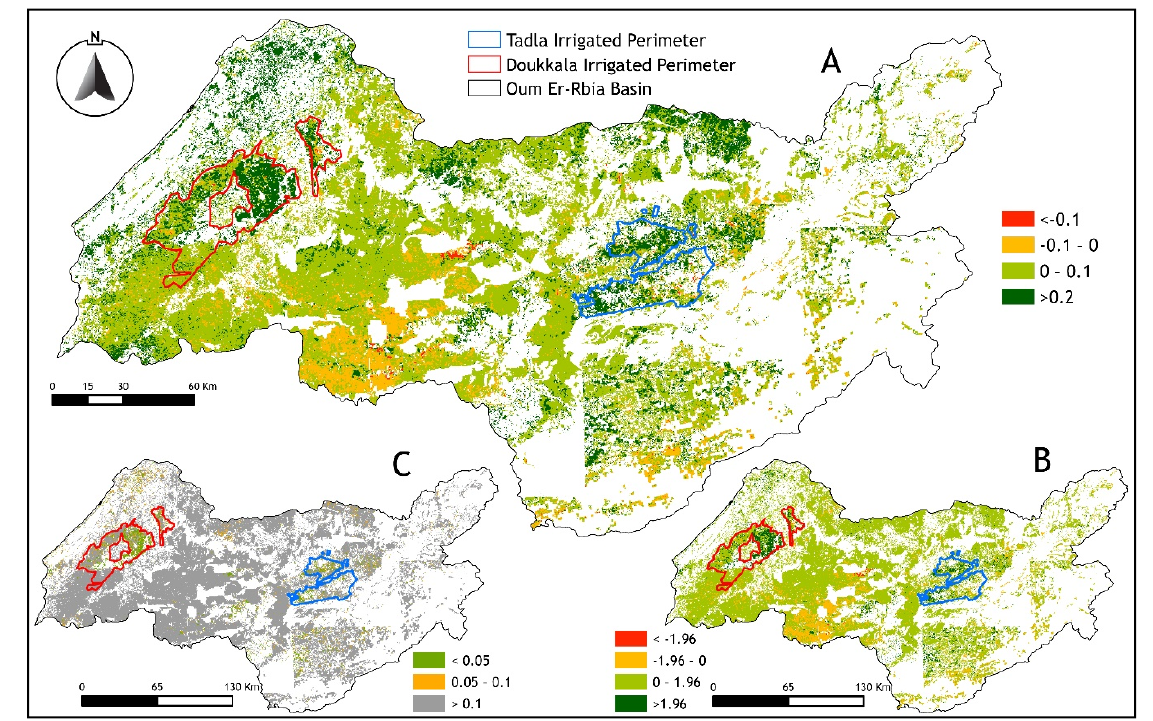
Figure 11. Spatial distribution of great integral (GINT) trend. Maps A, B, and C represent Sen’s slope values, Kendall Z, and p-value intervals, respectively.